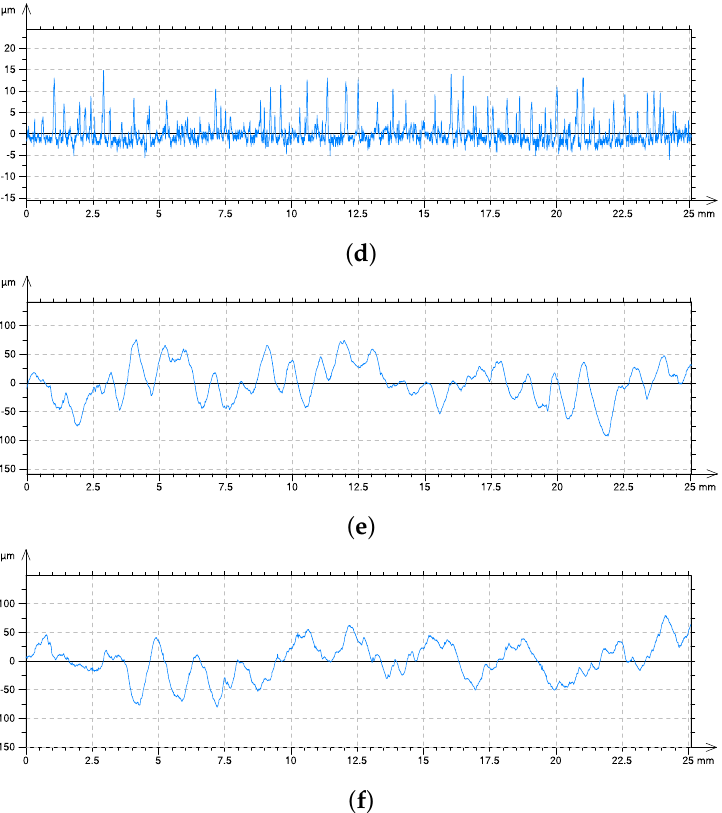
Figure 10. Surface condition of samples (profilograph ( µ m)) after the experiment, waviness + rough- ness: ( a ) I = 40 A, ω p = 1 rot/s, ( b ) I = 40 A, ω p = 2 rot/s, ( c ) I = 60 A, ω p = 1 rot/s, ( d ) I = 60 A, ω p = 2 rot/s, ( e ) I = 80 A, ω p = 1 rot/s, ( f ) I = 80 A, ω p = 2